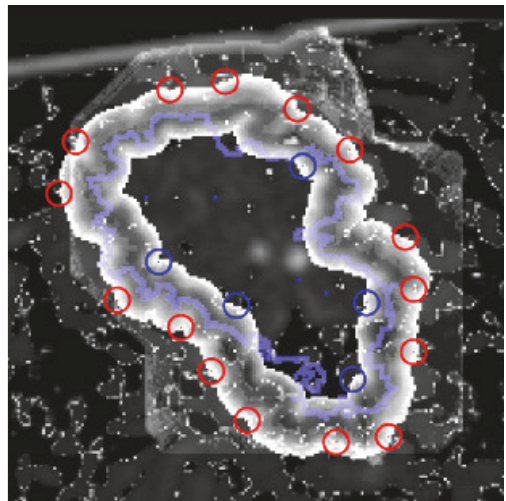
Figure 5: The approximated influence map for new seed point locations for the joint segmentation prototype. The map is generated by a weighted sum of gradient magnitude image, number of cell changes ℎ 푡=∞ 푒 per cell 𝑒 obtained from the previous GrowCut segmentation, and the distance to the contour line of the current